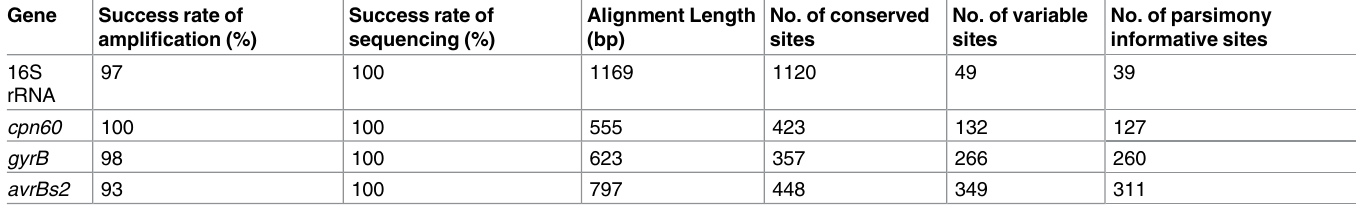
Table 2. Sample sizes, success rates of amplification and sequencing, and sequence characteristics of the four DNA regions in the Xanthomonas species assessedin this study. Gene Success rate of amplification